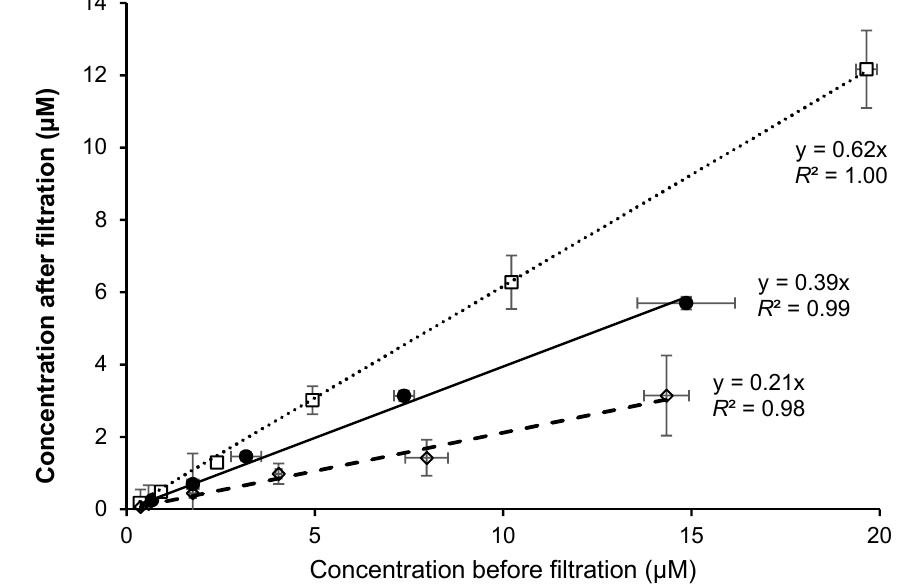
Figure 2. Incorporation of different forms of vitamin D in synthetic mixed micelles. Synthetic mixed micelles with varying concentrations of vitamin D forms were synthesized and the concentration of the different forms was measured by HPLC. Symbols: ● , D 3 ; □ , 1 α (OH)D 3 ; ◊ , 25(OH)D 3 . Values are mean ( n = 3) with their standard errors.